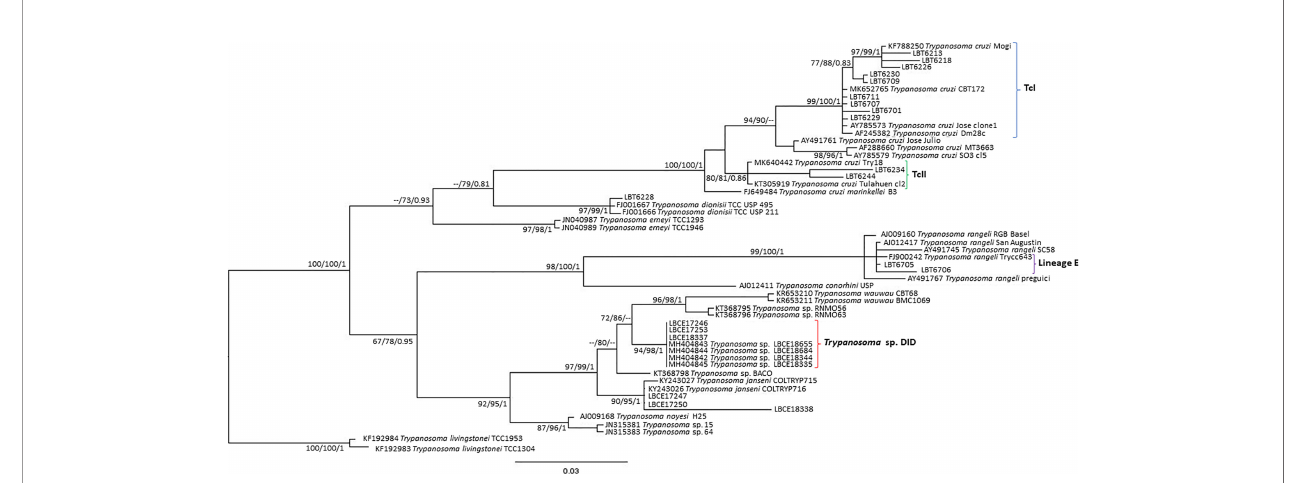
FIGURE 3 | Trypanosoma cruzi clade phylogenetic tree based on 692 base pair SSU rDNA fragment lengths from sylvatic mammal and dog blood clots. The tree was inferred using transitional3 with amino acid frequencies and freeRate heterogeneity (TIM3+F+R2) and generalized time reversible with amino acid frequencies plus gamma distribution (GTR+F+G) models for ML and BI, respectively. The numbers at nodes correspond to ML (ultrabootstrap and SH-aLRT) and BI (posterior probability). The scale bar shows the number of nucleotide substitutions per site. The blood clot samples grouped with T. cruzi, T. rangeli, Trypanosoma sp. DID and T. janseni . The blue curly brackets represent the sequences that grouped with T. cruzi TcI sequences. The green curly brackets represent the sequences that grouped with T. cruzi TcII/TcVI sequences. The purple curly brackets represent the sequences that grouped with T. rangeli lineage E sequences. The red curly brackets represent the sequences that grouped with Trypanosoma sp. DID